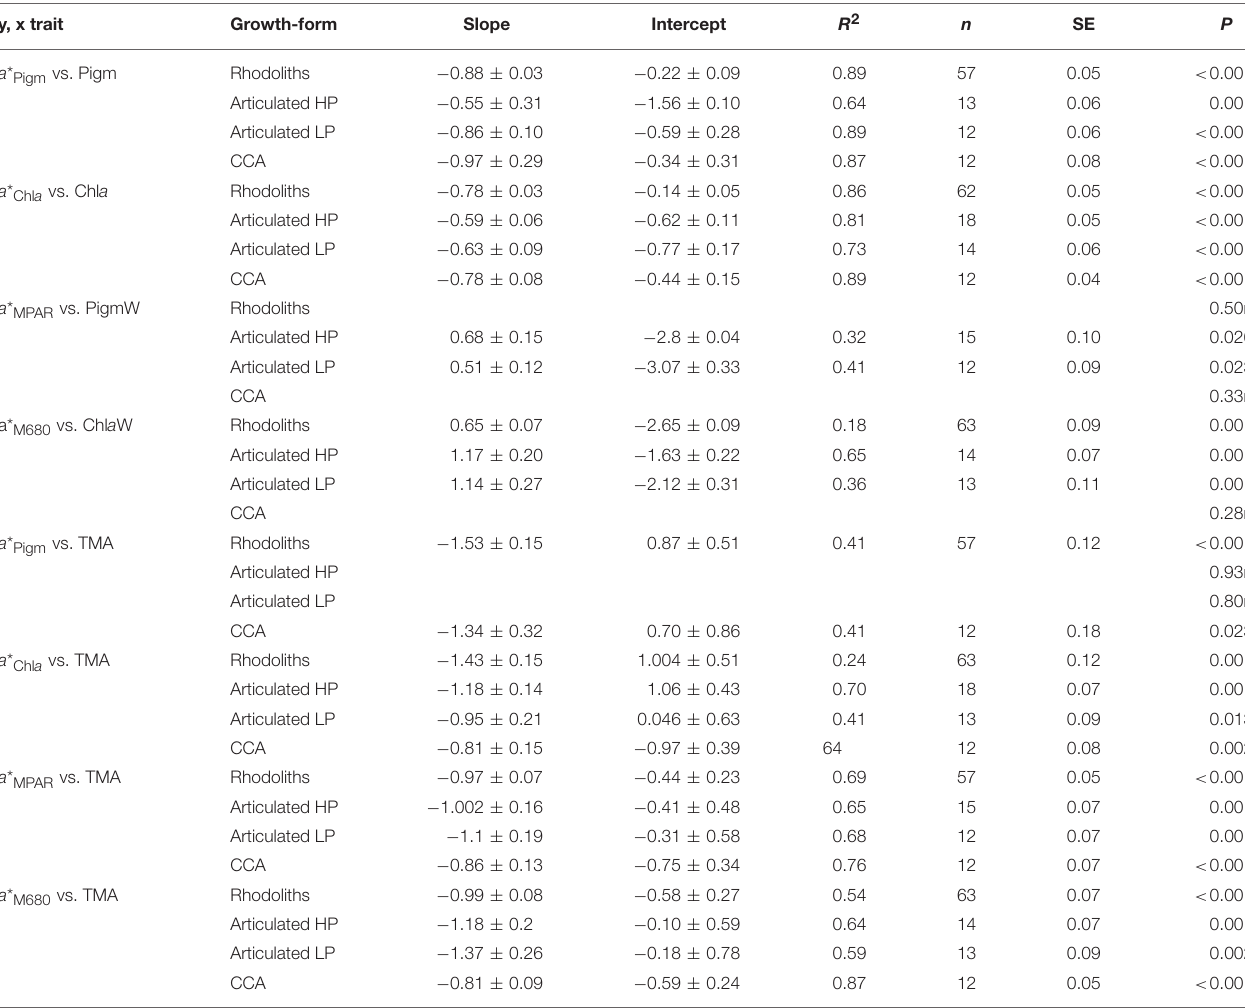
TABLE 3 | Slopes and intercepts of the linear associations (log-log transformed data) between the structural and optical descriptors of the three coralline species characterized in this study: the rhodolith Neogoniolithon sp., the articulated alga Amphiroa tribulus (both sides) and the crustose coralline (CCA) Lithothamnion sp. y, x trait Growth-form Slope